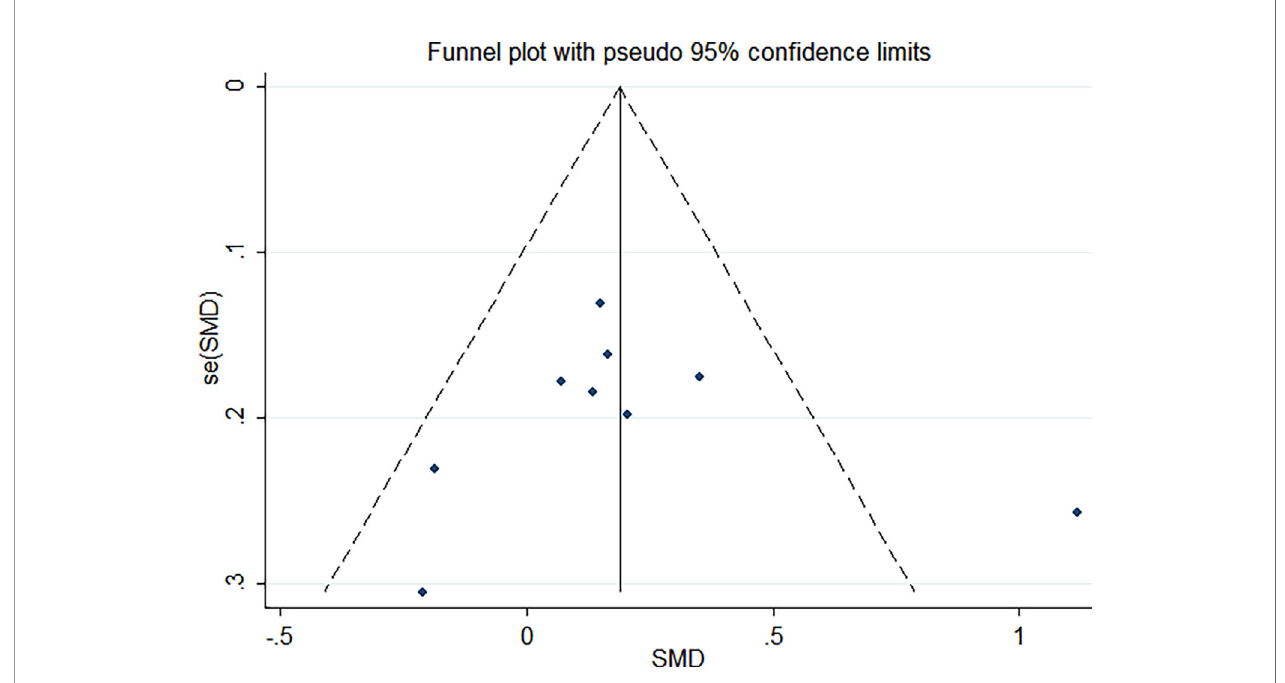
FIGURE 3 | Funnel plot of the publication